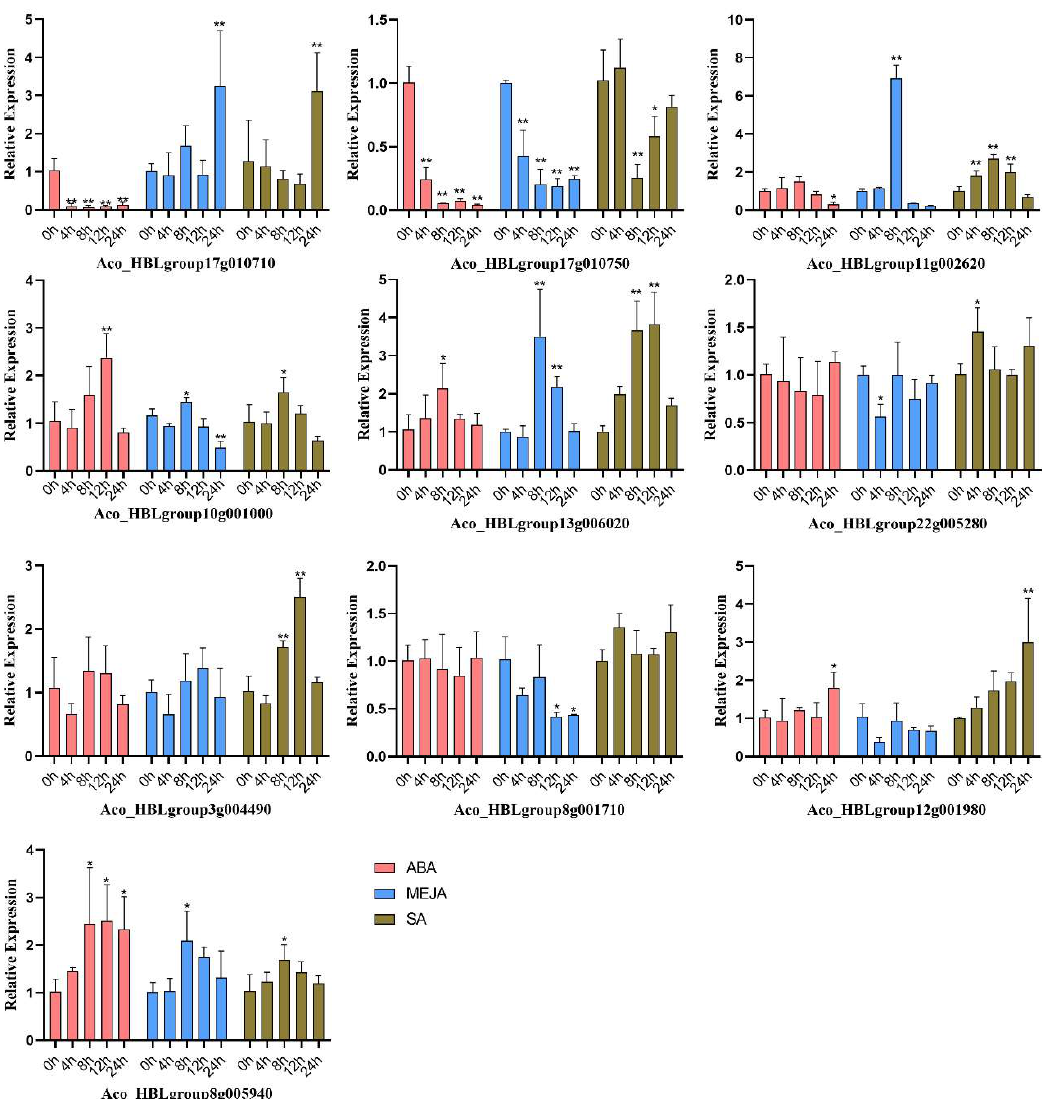
Figure 9. The relative expression levels of anthocyanin biosynthesis-related candidate AbR2R3-MYB genes under ABA, MEJA, and SA treatments. One asterisk and two asterisks indicate significant ( p < 0.05) and extremely significant ( p < 0.01) differences compared to the control, respectively.